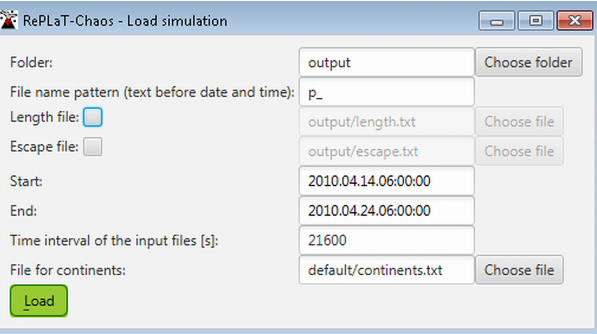
Figure A4. Setting simulation data for loading saved